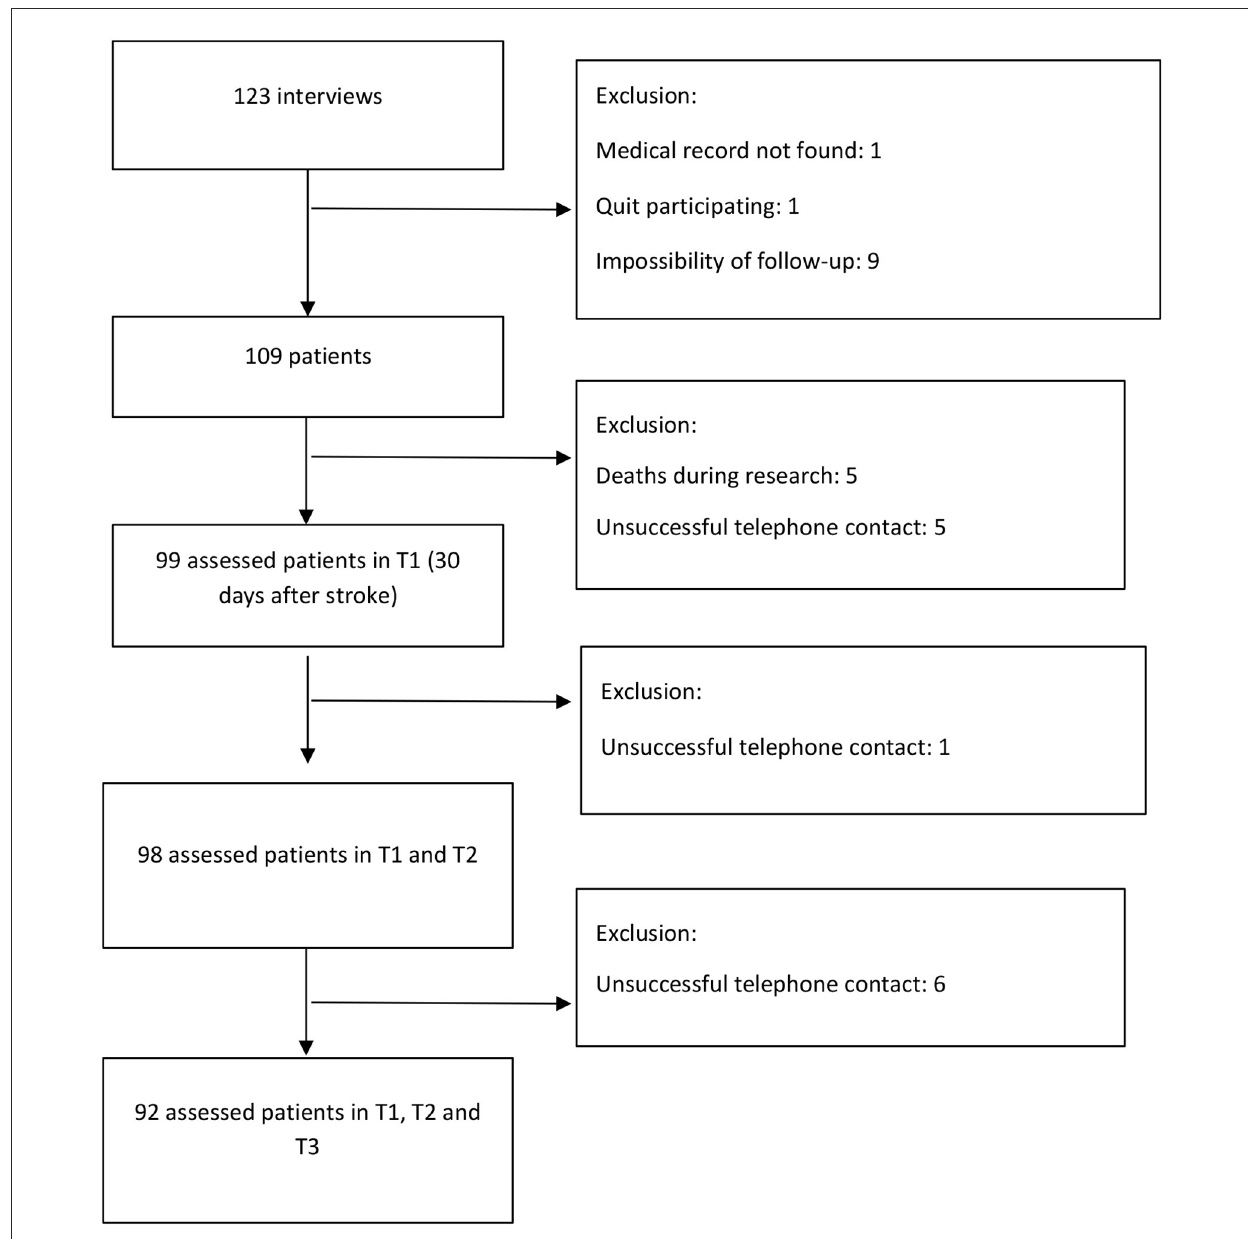
FIGURE1 Flowchart of patient selection for the